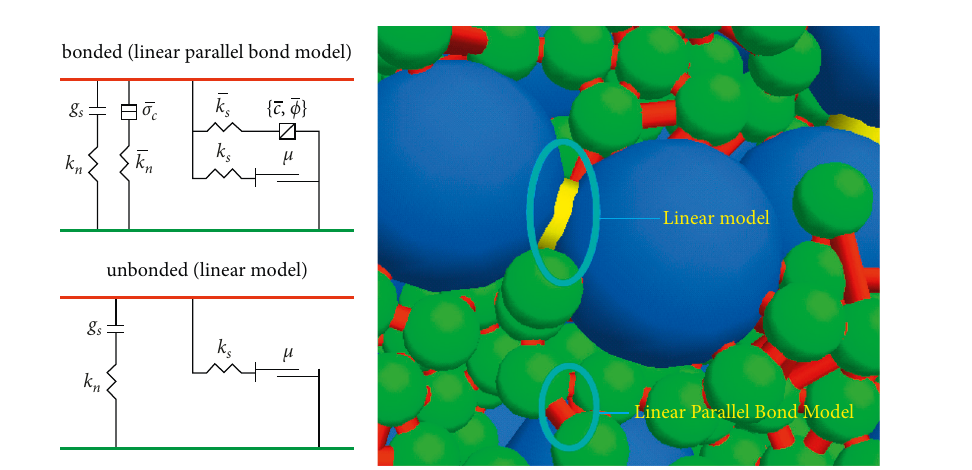
Figure 7: Contact model